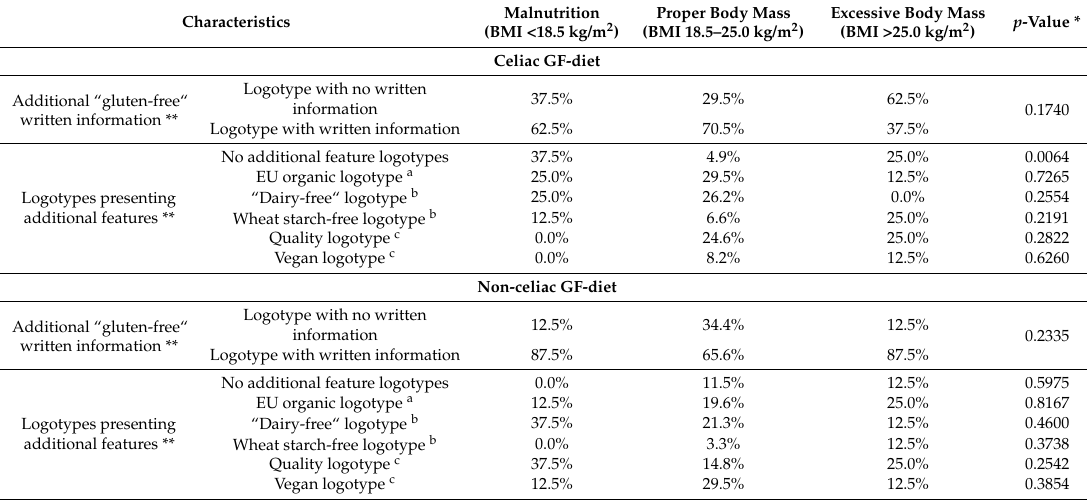
Table 7. The comparison of the front-of-package “gluten-free” (GF) product labeled attributes influencing the choice of GF bread in subgroups of celiac GF-diet and non-celiac GF-diet participants stratified by BMI.